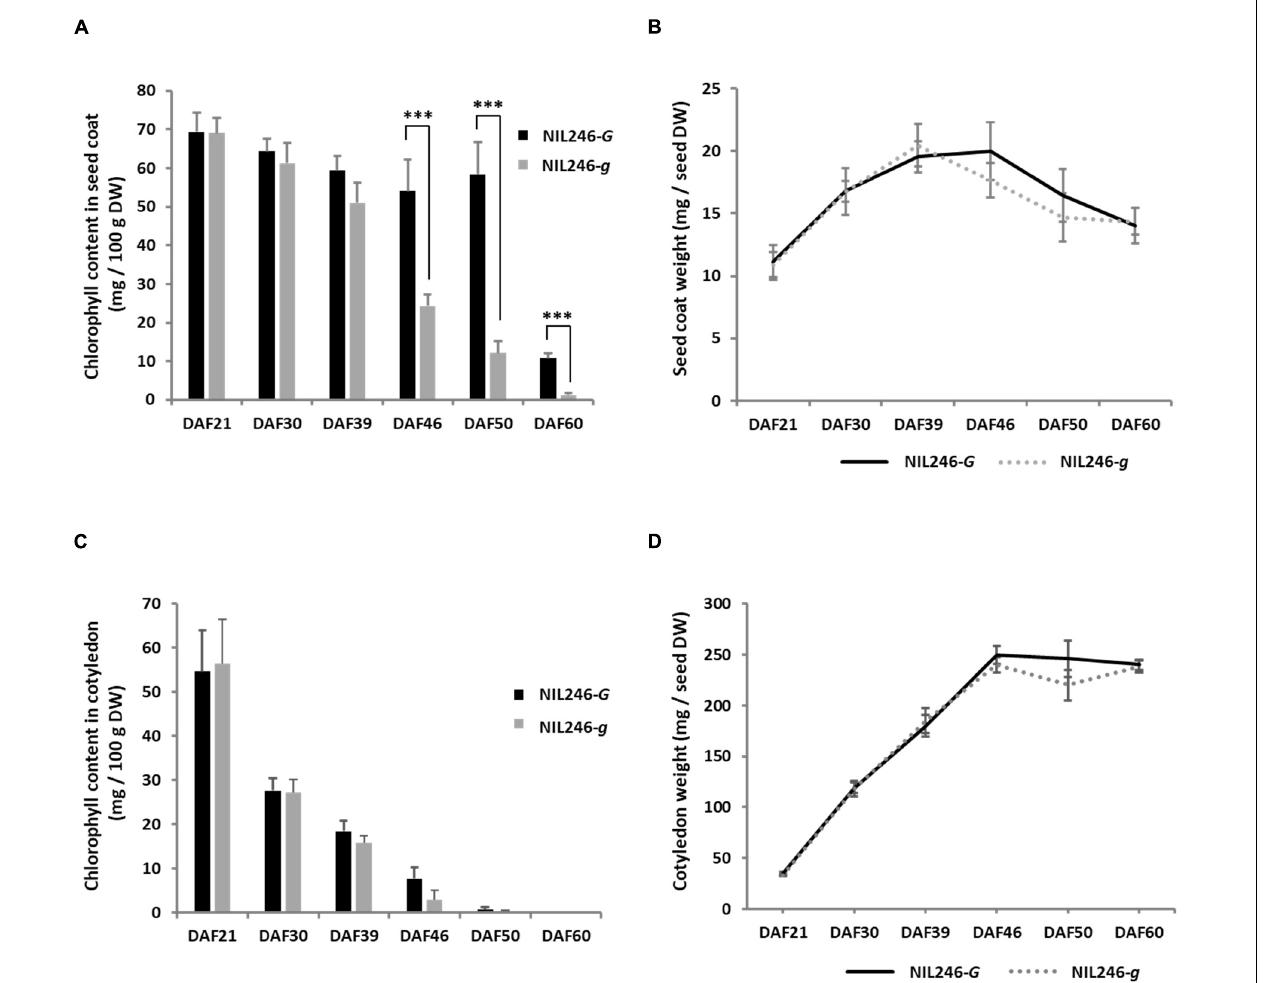
FIGURE 4 | Characterization of seed coats and cotyledons in NIL246s (yellow cotyledons). (A) Chlorophyll content of the seed coat. ∗∗∗ indicates the significant differences between NIL246- G and NIL246- g at the 0.1% level. (B) Seed coat weight per seed. (C) Chlorophyll content of the cotyledon. (D) Cotyledon weight per seed. All data shown are the mean ± SD of six